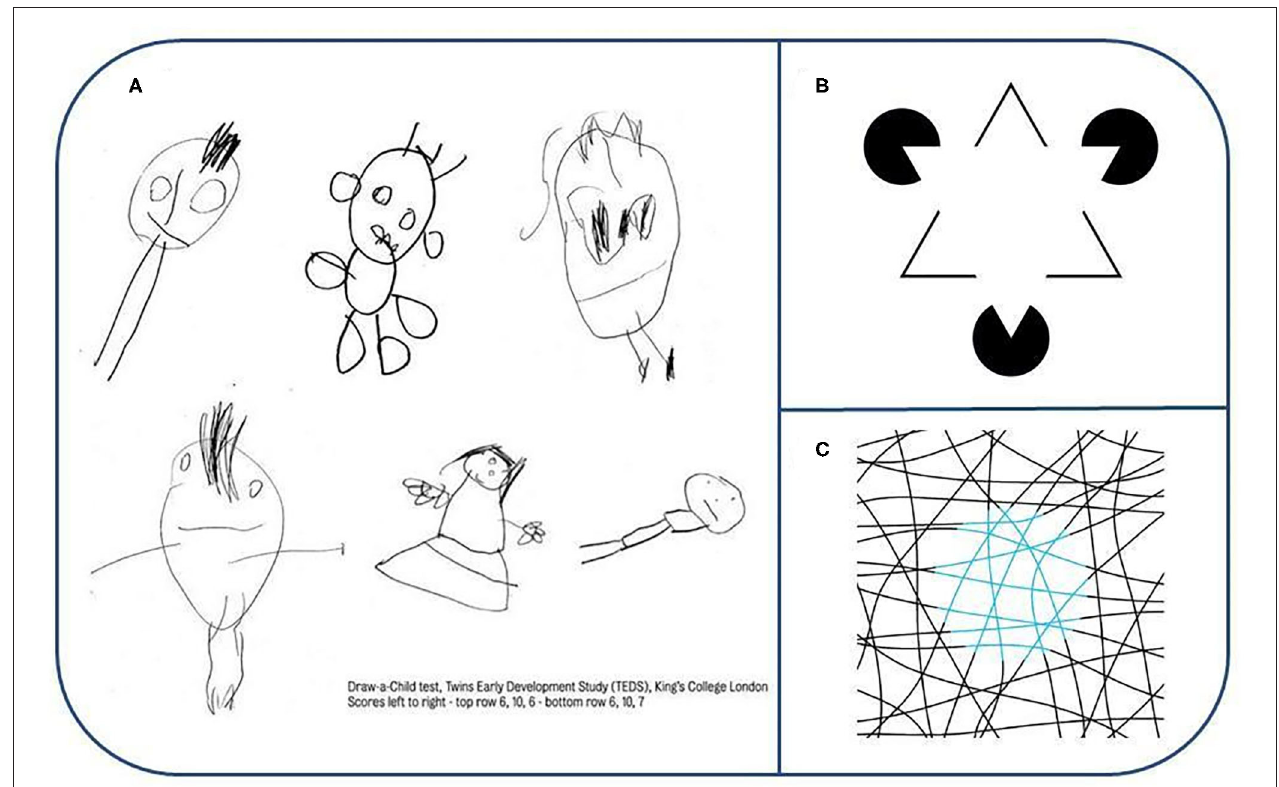
FIGURE 3 | (A) Draw-a-Child test. Note the quality of the drawings and that many of the components of the body as well as components of the face are depicted in these drawings. Reproduced with permission from King’s College London. Their work was supported by the following grants: MRC grant G0901245 & NIH HD044454 & HD059215. (B) Examples for component related illusion: Kanizsa triangle illusion. White color is identical everywhere. Edges—in our framework—are Lego-like, i.e., summable (CF1) components being inserted into the representation via a pattern completion machinery that eventually gives rise to apparent differences in color. Reproduced from https://en.wikipedia.org/wiki/Gaetano_Kanizsa#/media/File:Kanizsa_triangle.svg under CC BY 3.0 license. (C) Example for qualia related illusion: Neon color spreading illusion (lines are black and blue). There are only three colors—white, black and light blue—in the figure. Small rotation of the disk region that looks light blue removes the illusion, leaving only light blue lines against a white background (see at https://michaelbach.de/ot/col-neon/index.html). A pixel wise examination of the image reveals the true colors. The interpretation of the illusion is that color, a CF2, is separated from shape during processing and regions are refilled during the decoding process that may modify the input at certain levels of the processing hierarchy alike to the case of binocular rivalry (see text). Reproduced from https://commons.wikimedia.org/w/index.php?curid=29960445 under CC BY-SA 3.0 license. Original source: http://www.blelb.com/spot005/spot005_de.html.